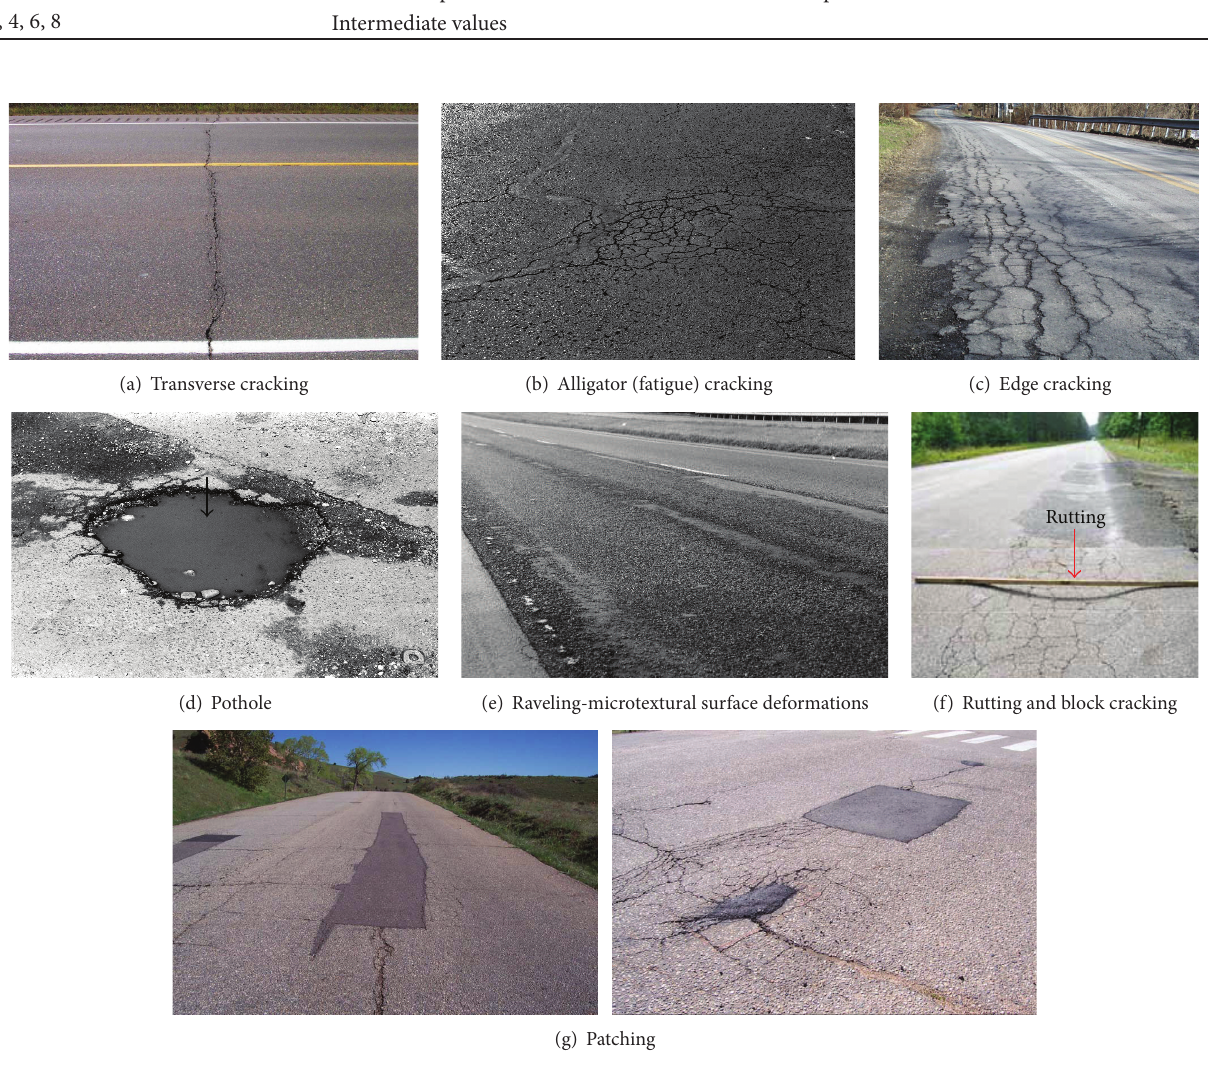
Figure 5: Photographs of typically observed road pavement